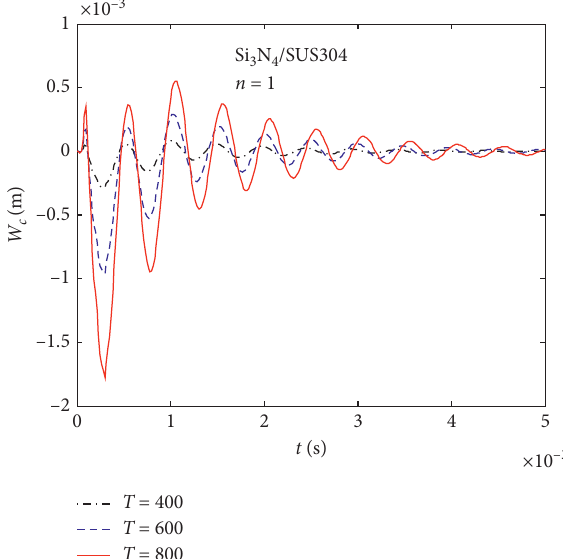
Figure 8: The dependence of ϕ T � 300K, SSSS.